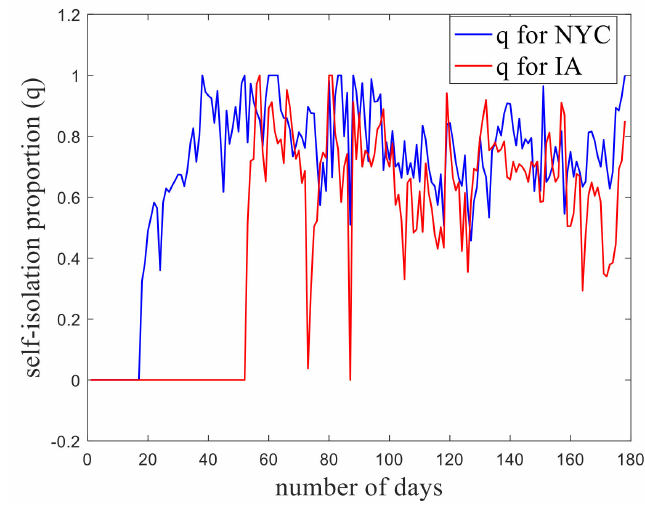
Figure 5. The change curve of self-isolation proportion ( q ) of NYC and Iowa (IA).